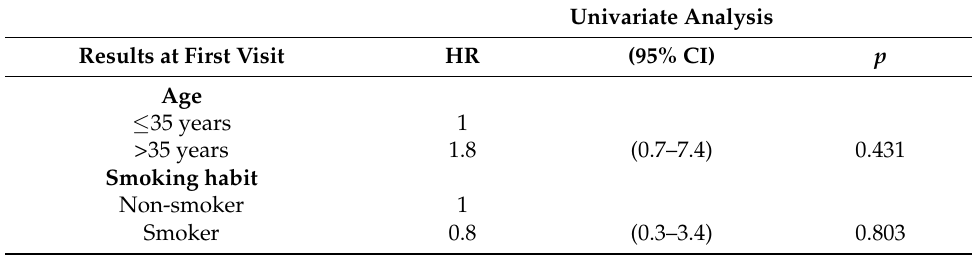
Table 3. Estimation of the risk of progression to high-grade squamous intraepithelial